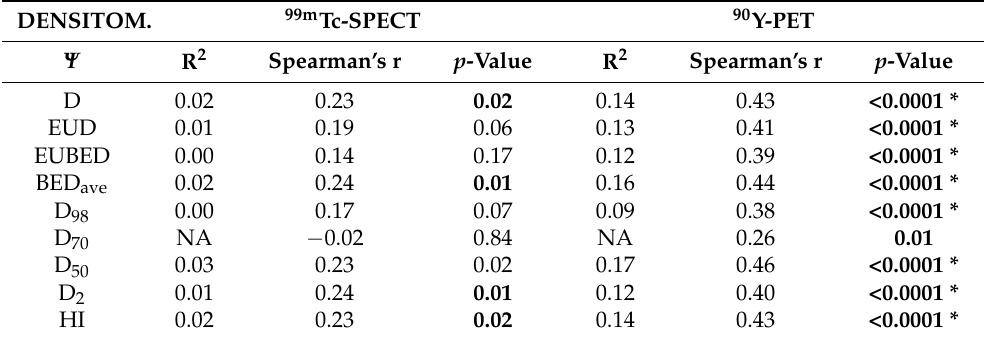
Table 4. R 2 , Spearman’s r, and p -values obtained with the 99m Tc-SPECT and 90 Y-PET data for the Ψ –densitometric method response correlation evaluation (Equation